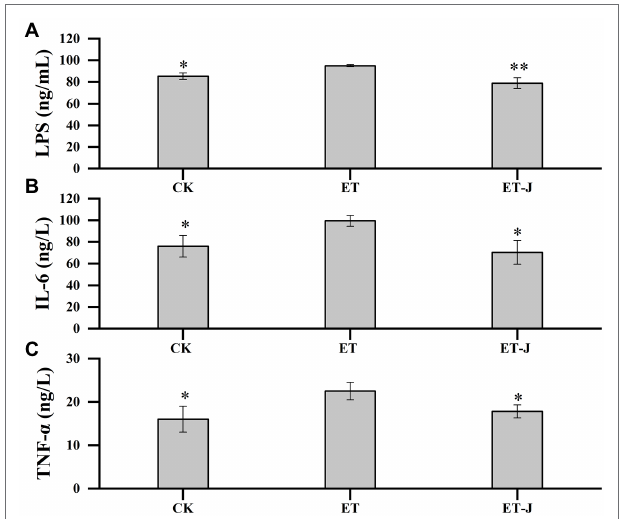
FIGURE 2 | Effect of fermentation broth on (A) liver index and activity of (B) alanine aminotransferase (ALT) and (C) aspartate aminotransferase (AST) in serum. CK, mice were administrated with 0.9% normal saline; ET, mice were administrated with liquor; and ET-J, mice were administrated with liquor and fermentation broth (0.1 ml/10 g). Results are expressed as the mean ± SD ( n = 14). * p < 0.05 vs. ET.